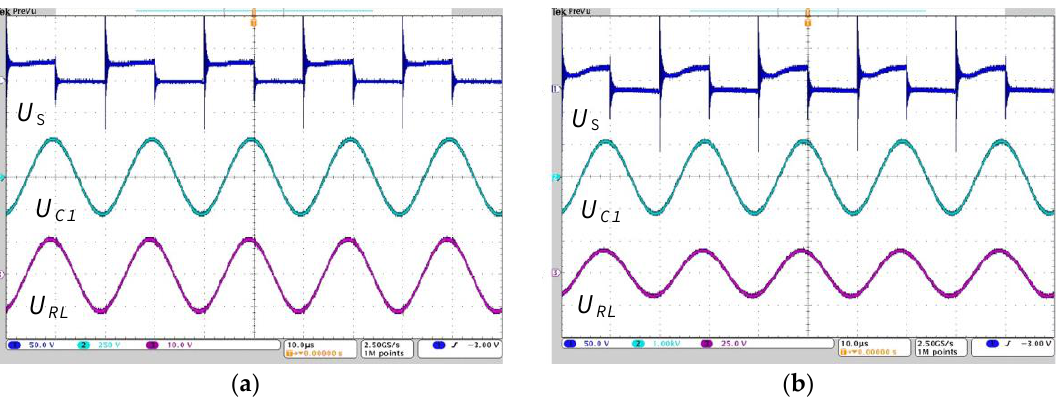
Figure 15. Experimental waveforms of experiment. ( a ) h = 5 cm ( b ) h = 10 cm.